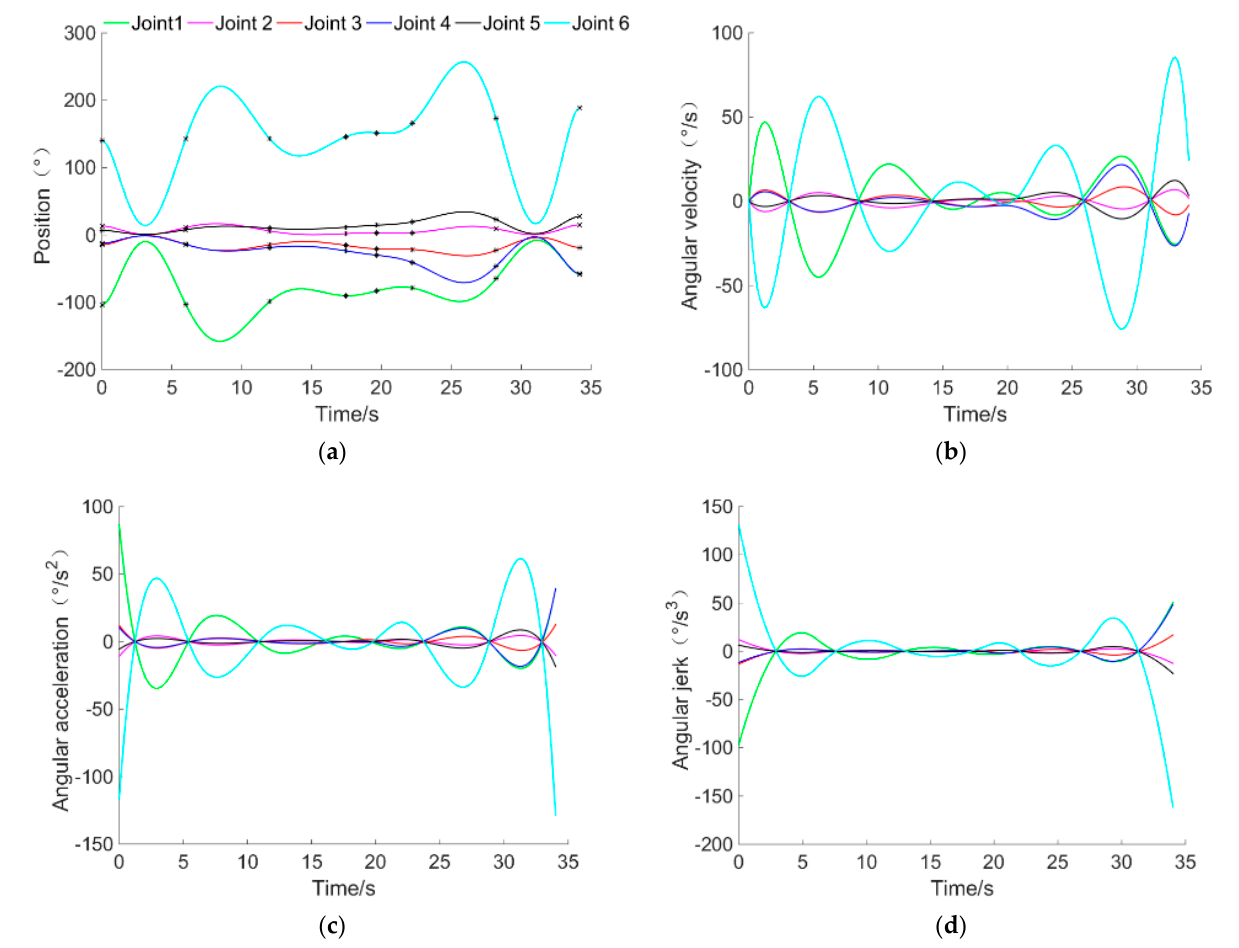
Figure 11. The optimal solution trajectory; ( a ) Position − Time chart of each joint; ( b ) Speed − Time chart of each joint speed; ( c ) Acceleration − time chart of each joint; ( d ) Jerk − time chart of each joint.